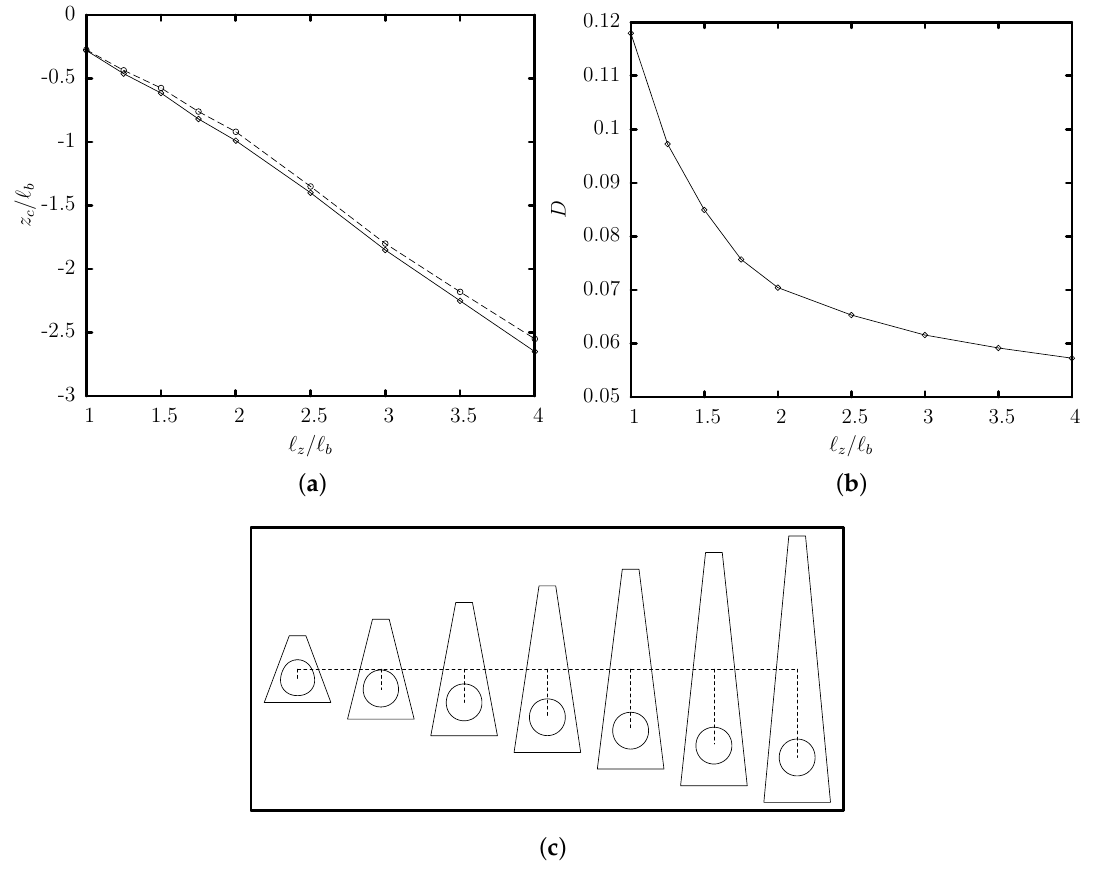
Figure 6. Steady-state variation with the channel height (cid:96) z of ( a ) the centroid z c and ( b ) the deformation D , for a capsule with a / (cid:96) b = 0.55 and Ca = 0.1 flowing in a trapezoidal channel with base ratio (cid:96) a / (cid:96) b = 0.25. In ( a ) also included is the location of the maximum inlet velocity (---). ( c ) The steady-state side profile (i.e., intersection of the system surface with the plane x = x c ) for channel height (cid:96) z / (cid:96) b =